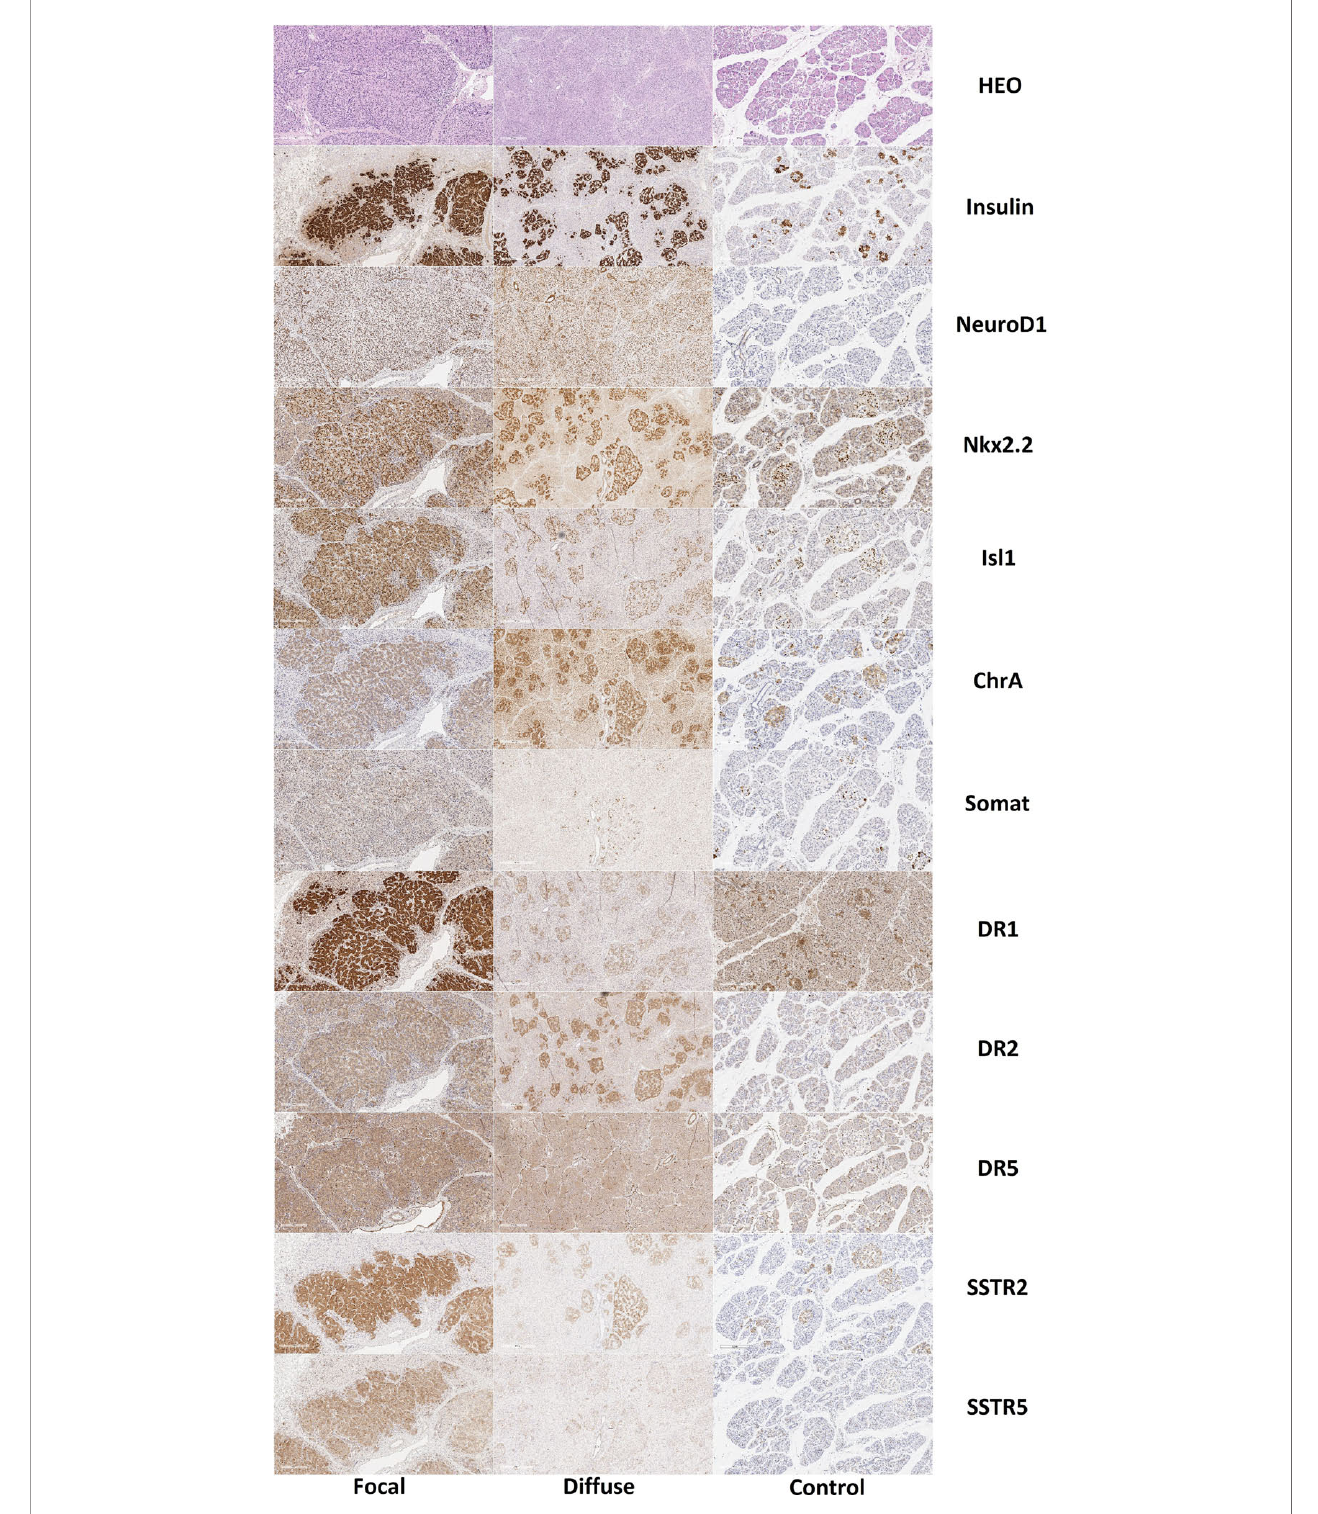
FIGURE 8 | Histological and immunohistochemical examination of pancreatic tissue in patients with congenital hyperinsulinism and in controls. Hematoxylin and eosin staining, insulin, NeuroD1 and Nkx2.2, Isl1, chromogranin A, somatostatin and DR1, DR2, DR5, SSTR2 and SSTR5; x50. Note: HEO – hematoxylin and eosin, Somat – somatostatin, ChrA – chromogranin A.